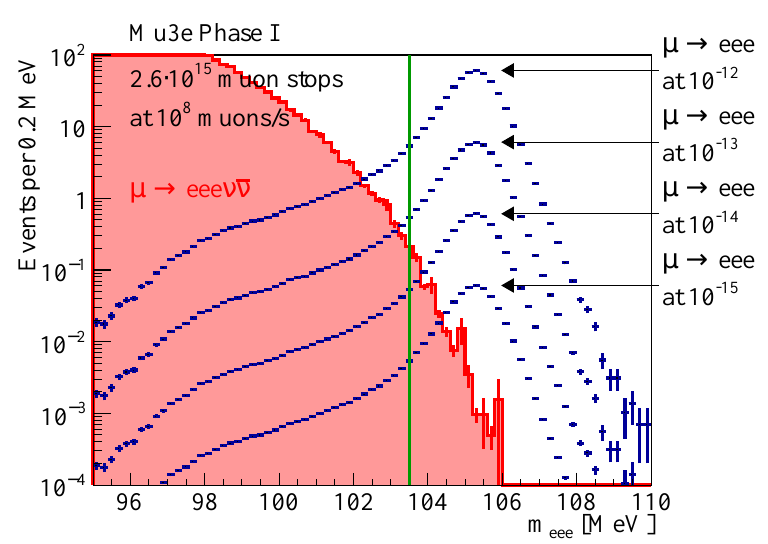
Figure 5: Expected distribution of the reconstructed invariant mass of µ → eee can- didates. Background from µ → eee νν decays is shown in red. The signal distribution (blue) is given for various assumptions on the µ → eee branching fraction. The ap- plied cut on the three electron mass is indicated by the green